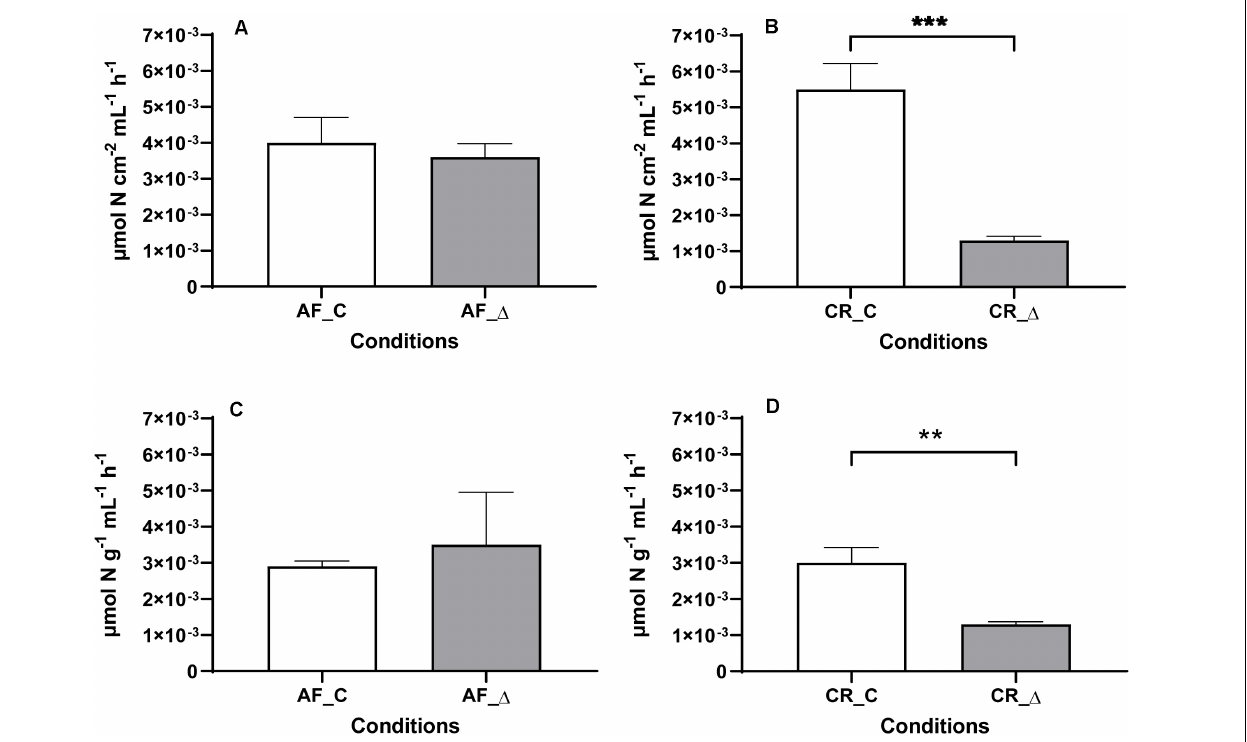
FIGURE 1 | Mean and standard deviation ( n = 3) of potential nitrification rates ([ 15 N]O 2 − + [ 15 N]O 3 − produced) measured in the sediments subjected to daily salinity fluctuations (AF_ (cid:49) and CR_ (cid:49) ) and constant salinity (AF_C and CR_C) treatments. Rates were measured with the same salinity (0 psu for Crestuma sediments, and 15 for Afurada sediments). Nitrification rates are displayed in four different charts corresponding to Afurada (AF) reactors (A) and Crestuma (CR) reactors (B) after addition of 20 µ M of [ 15 N]H 4 + ), and Afurada slurries (C) and Crestuma slurries (D) after addition of 100 µ M of [ 15 N]H 4 + ). Symbol ** and *** means a P < 0.01 and P < 0.001,